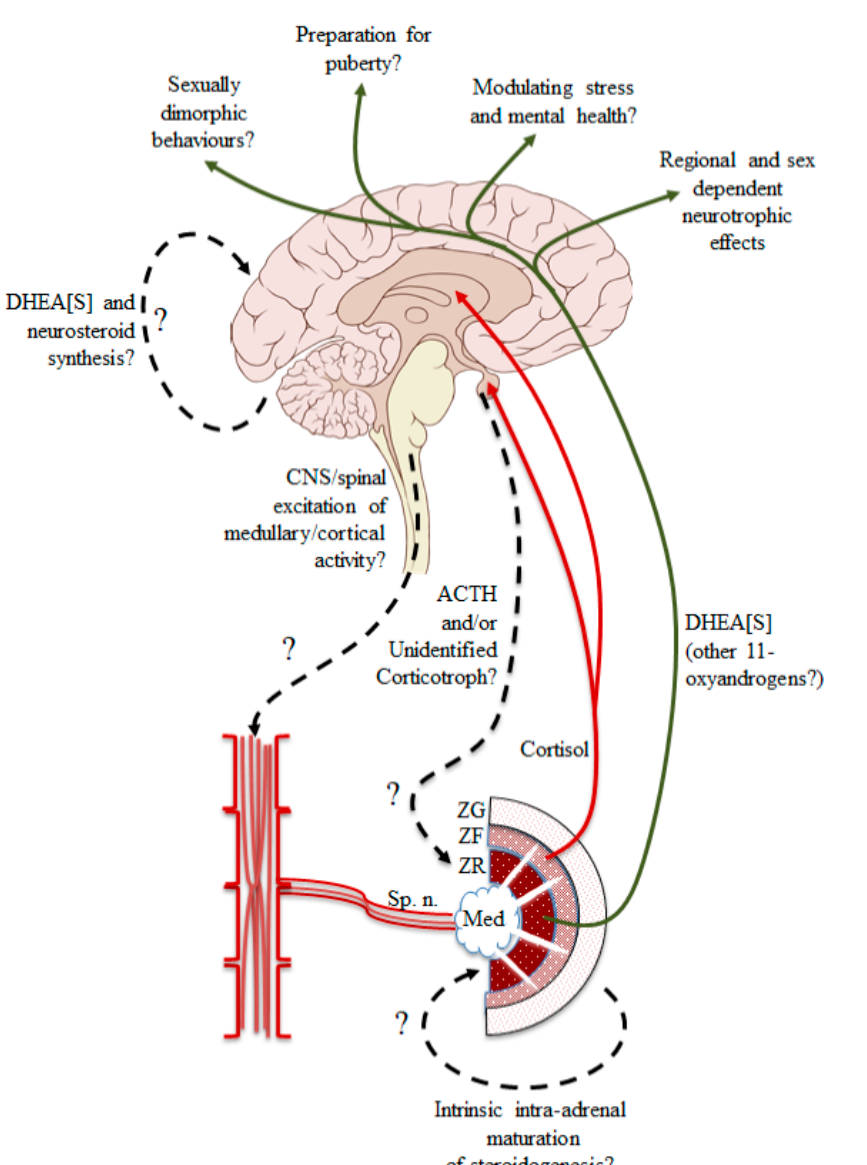
Figure 2. Summary of the putative descending pathways impacting the adrenal gland at adrenarche (descending spinal-sympathetic drive, pituitary derived ACTH and/or an unidentified corticotropic substance), together with the intra-adrenal maturation of paracrine influences on the ZR. The established effects of DHEA[S] on the brain are shown, with the recently described 11-oxyandrogens as possible co-modulators of brain activity and development. Coordinated changes of adrenal and CNS DHEA[S] synthesis are also suggested. Med = medulla. Brain image adapted from [85] under